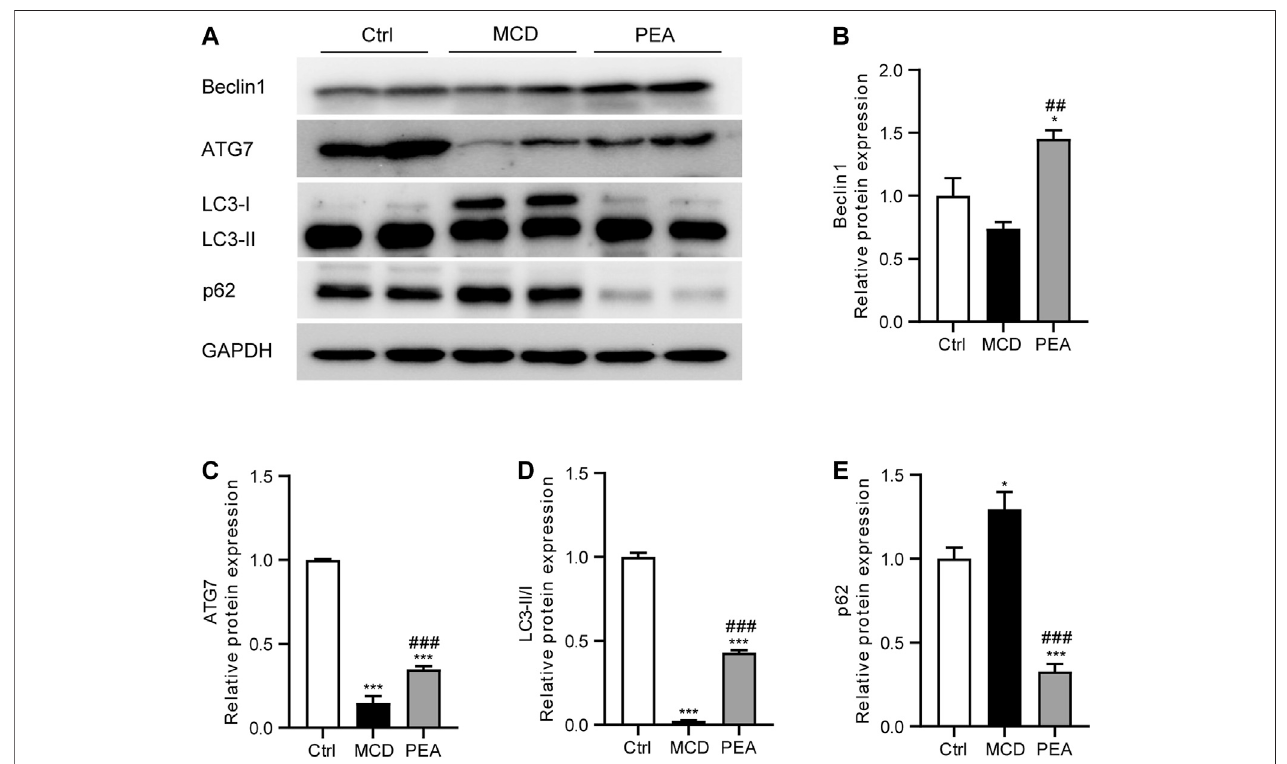
FIGURE 6 | PEA enhanced autophagy during NASH. (A – E) Protein expression of hepatic Beclin1, ATG7, LC3II/I, and p62 levels. Ctrl: the mice treated with standarddiet;MCD:themicetreatedwithMCDdiet;PEA:themicetreatedwithMCDdietandPEA.Valueswereexpressedasthemean ± SEM, n (cid:1) 6 – 8foreachgroup. * p < 0.05, *** p < 0.001 versus the Ctrl group; ## p < 0.01, ### p < 0.001 versus the MCD